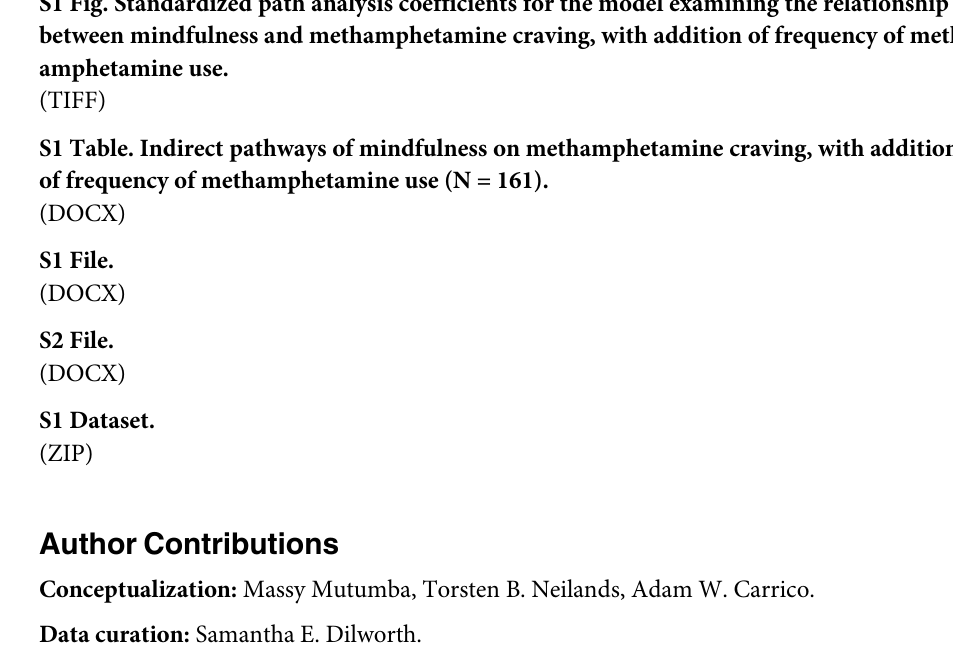
S1 Fig. Standardized path analysis coefficients for the model examining the relationship between mindfulness and methamphetamine craving, with addition of frequency of meth- amphetamine use. S1 Table. Indirect pathways of mindfulness on methamphetamine craving, with addition of frequency of methamphetamine use (N =